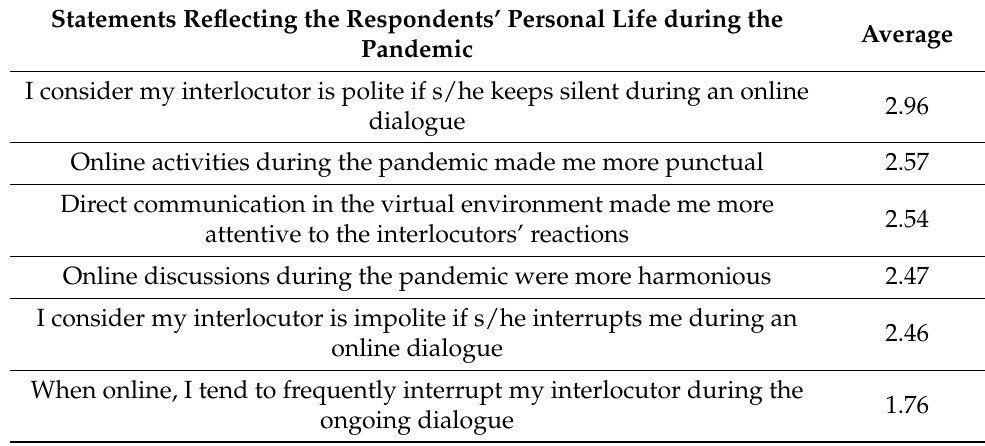
Table 3. Statements reflecting the respondents’ personal life during the